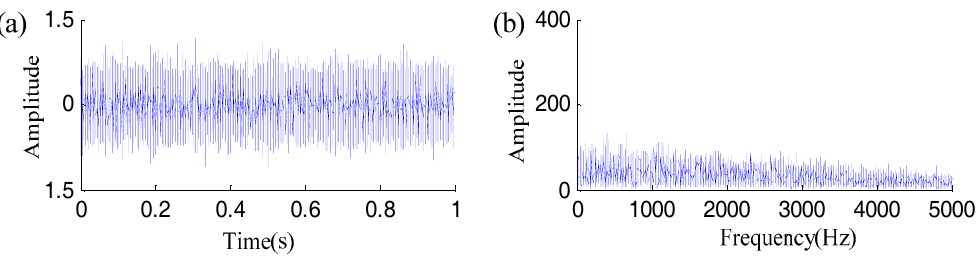
Figure 5. The time and frequency waveform of the first detail signal. (a ) The waveform of the first detail signal in the time-domain. (b) The waveform of the first detail signal in the frequency-domain.